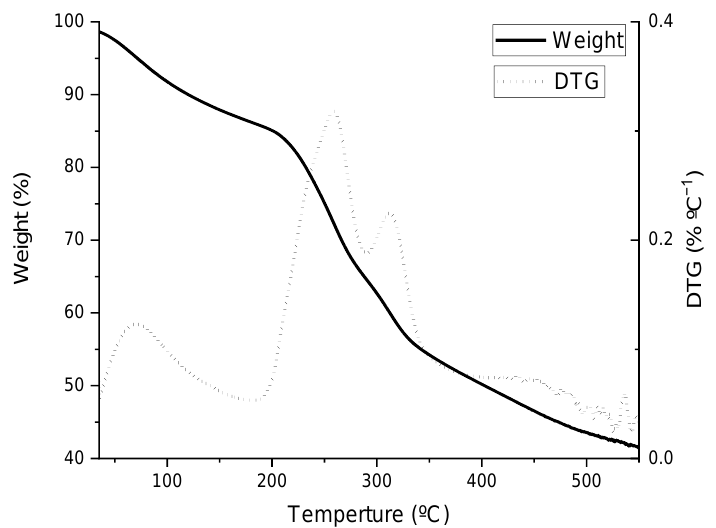
Figure 5. Thermogravimetric curves of Sargassum weight loss.